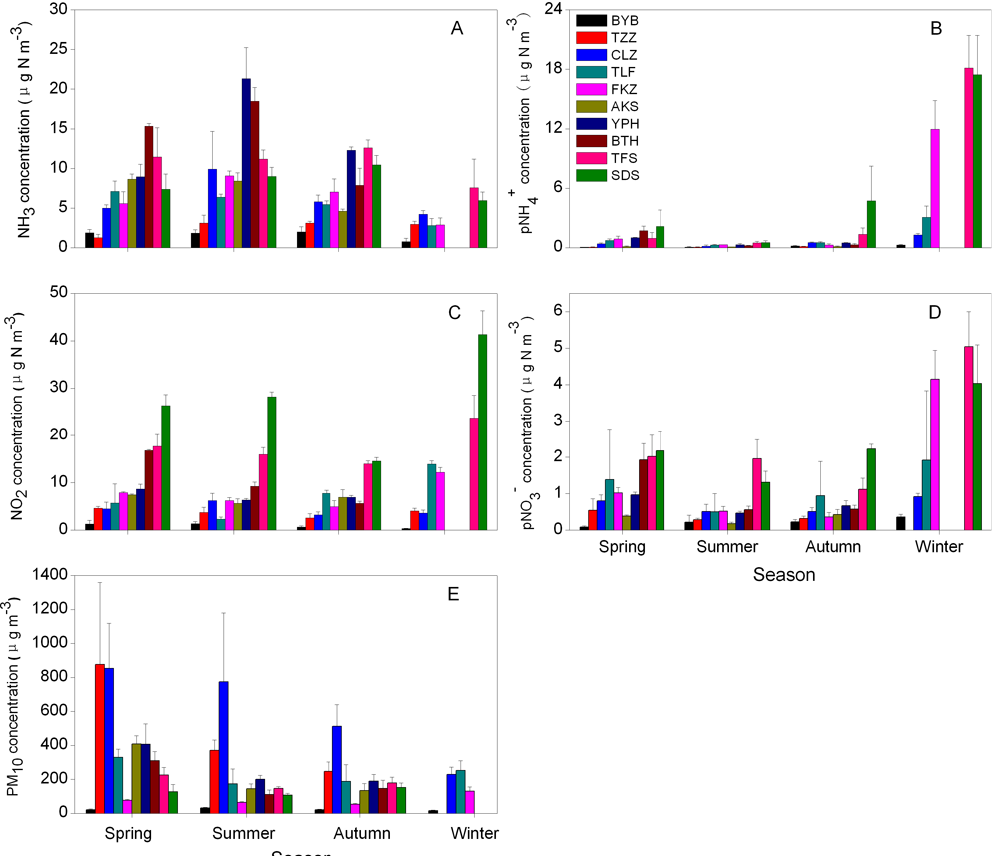
Fig. 4. Seasonal concentrations of (A) NH 3 , (B) p NH + winter denote the periods from December to February, March to May, June to August, and September to November,